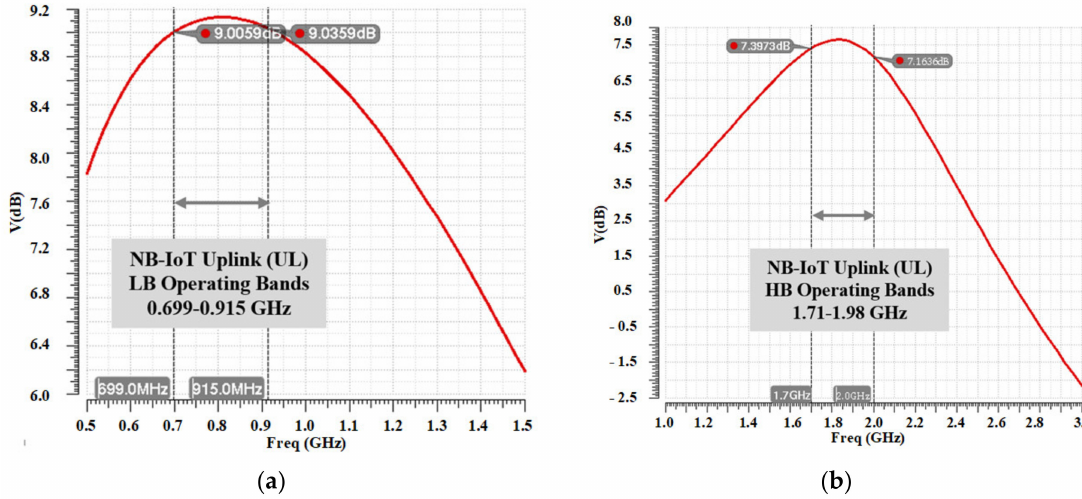
Figure 8. Optimized AC response for ( a ) low and ( b ) high